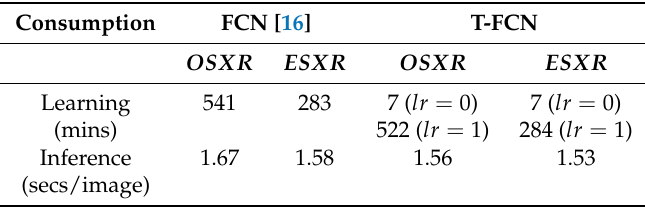
Table 7. Time cost of prior and proposed image